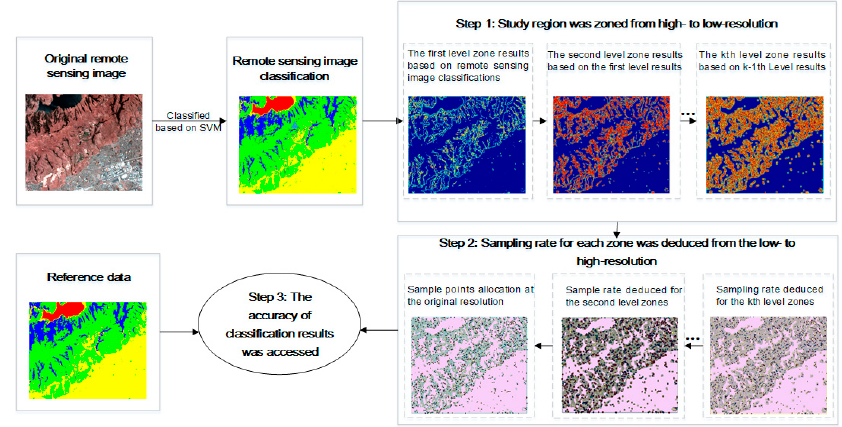
Figure 1. Overall flow of accuracy assessment of remote sensing image classification results based on the multi-level non-uniform spatial sampling method